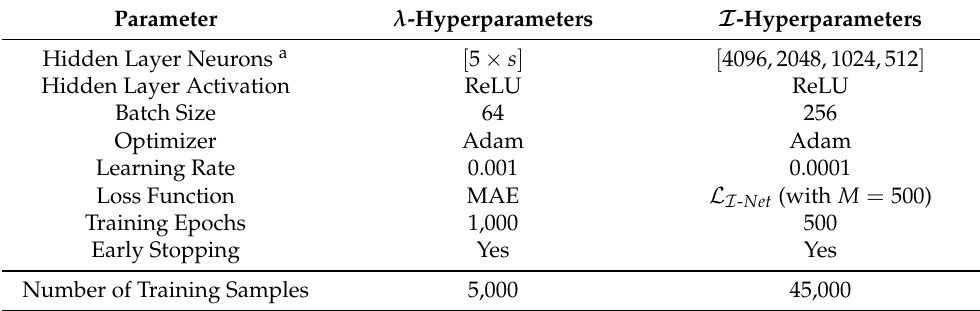
Table 2. Parameters used for the λ -Net and I -Net training.